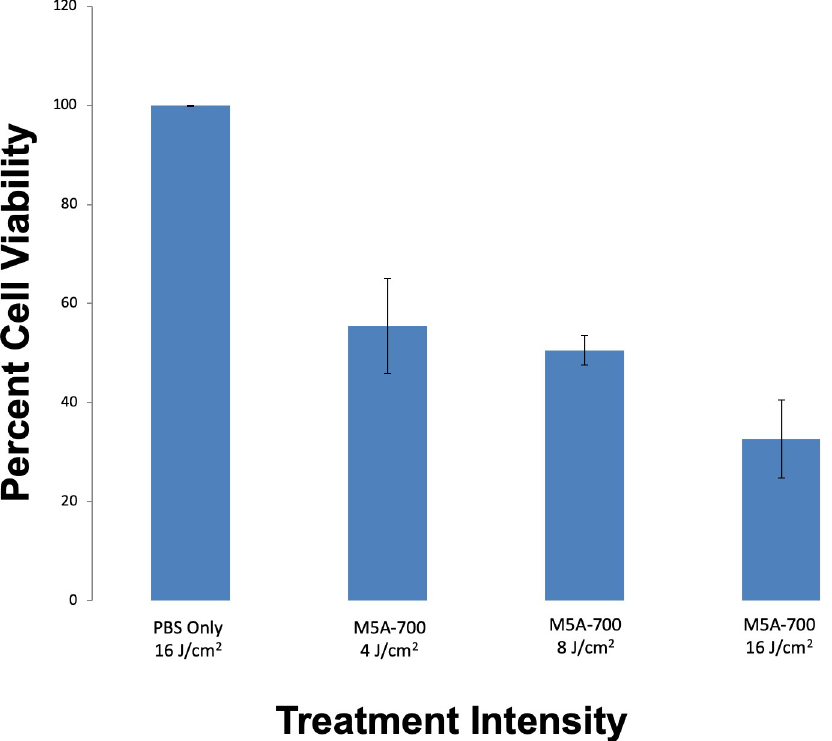
Fig 2. In vitro PIT cell viability with increasing exposure to laser intensities. LS174T cells (2,000) were seeded into each well. Treatment groups were incubated with media containing m5A-700. Lower levels of cell viability were demonstrated in a dose-dependent fashion, with the lowest percentage of cell viability in wells that received 16 J/cm 2 of laser exposure (p < 0.001).